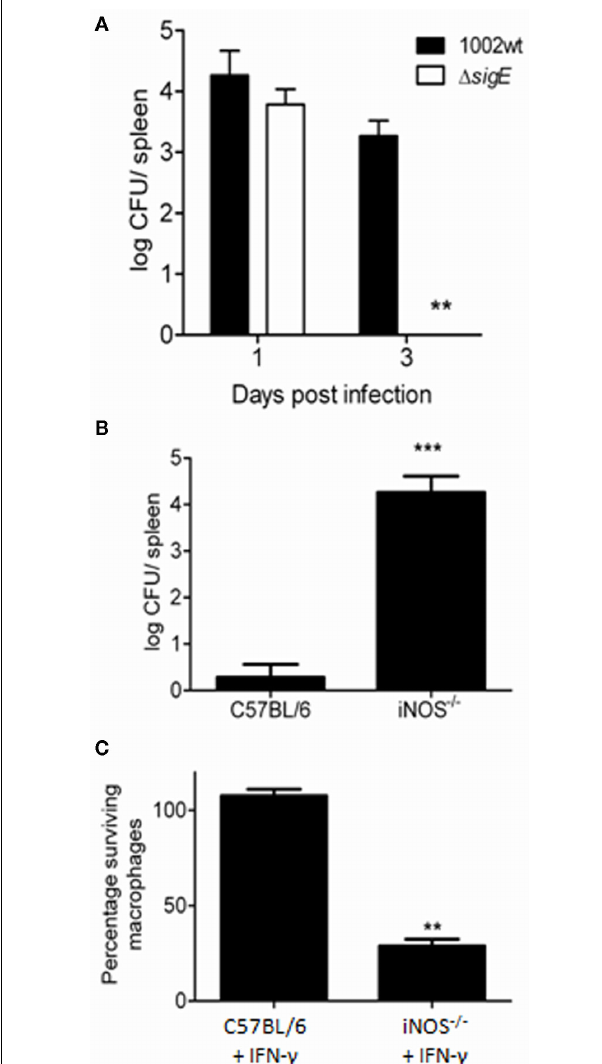
FIGURE 3 | Differential persistence of the Δ sigE mutant of C. pseudotuberculosis during infection of wild-type and iNOS − / − mice. (A) The Δ sigE strain is rapidly eliminated, becoming almost undetectable in the spleens of C57BL/6 mice 3days after inoculation with 10 6 CFU. (B) Bacterial loads in spleens of C57BL/6 or iNOS − / − mice, 3days post-infection with the Δ sigE strain of C. pseudotuberculosis . (C) Viability of macrophages obtained from either C57BL/6 or iNOS − / − mice, 4h post-infection with the Δ sigE strain of C. pseudotuberculosis . ** t -Test p < 0.001; *** t -test p <